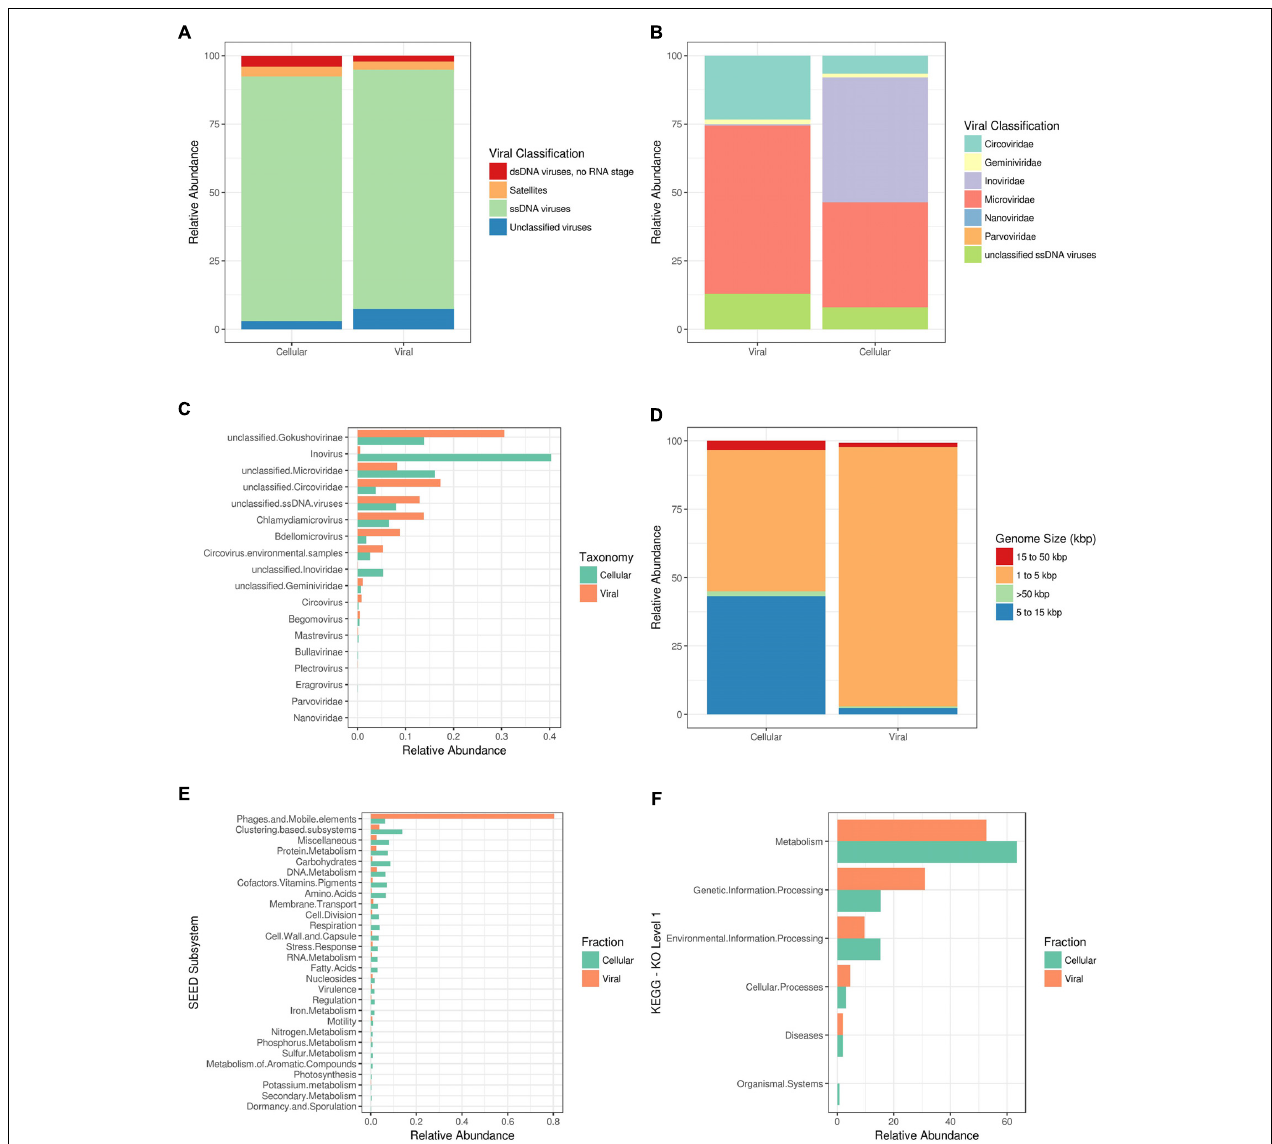
FIGURE 1 | Shark Bay viral and cellular fraction comparison. MG-RAST Functional annotations using KEGG (KO) and SEED where based on BLAT based comparison ( e -value ≤ 10 − 5 ) against respective database. (A) Viral taxonomic classification characterization by nucleic acid state in MetaVir2. (B) Viral taxonomic classification characterization by viral family in MetaVir2. (C) Viral taxonomic classification characterization by viral genus in MetaVir2 by cellular or viral fraction metagenome. (D) GAAS predictive viral genome size estimations in MetaVir2. (E) SEED subsystem functional annotations in MG-RAST. (F) KEGG (KO) level 1 functional annotations in MG-RAST. MetaVir2 viral (BLAST) based comparison ( e -value ≤ 10 − 5 ) against NCBI viral refseq database and normalized to genome length using the built-in Genome-relative Abundance and Average Size (GAAS) normalization tool (Angly et al., 2006).